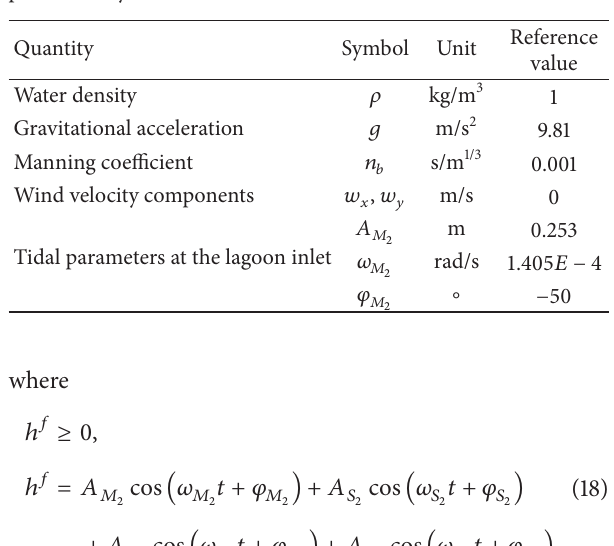
Figure 2: Time evolution of predicted average contaminant concen- tration 𝐶 𝐴 .